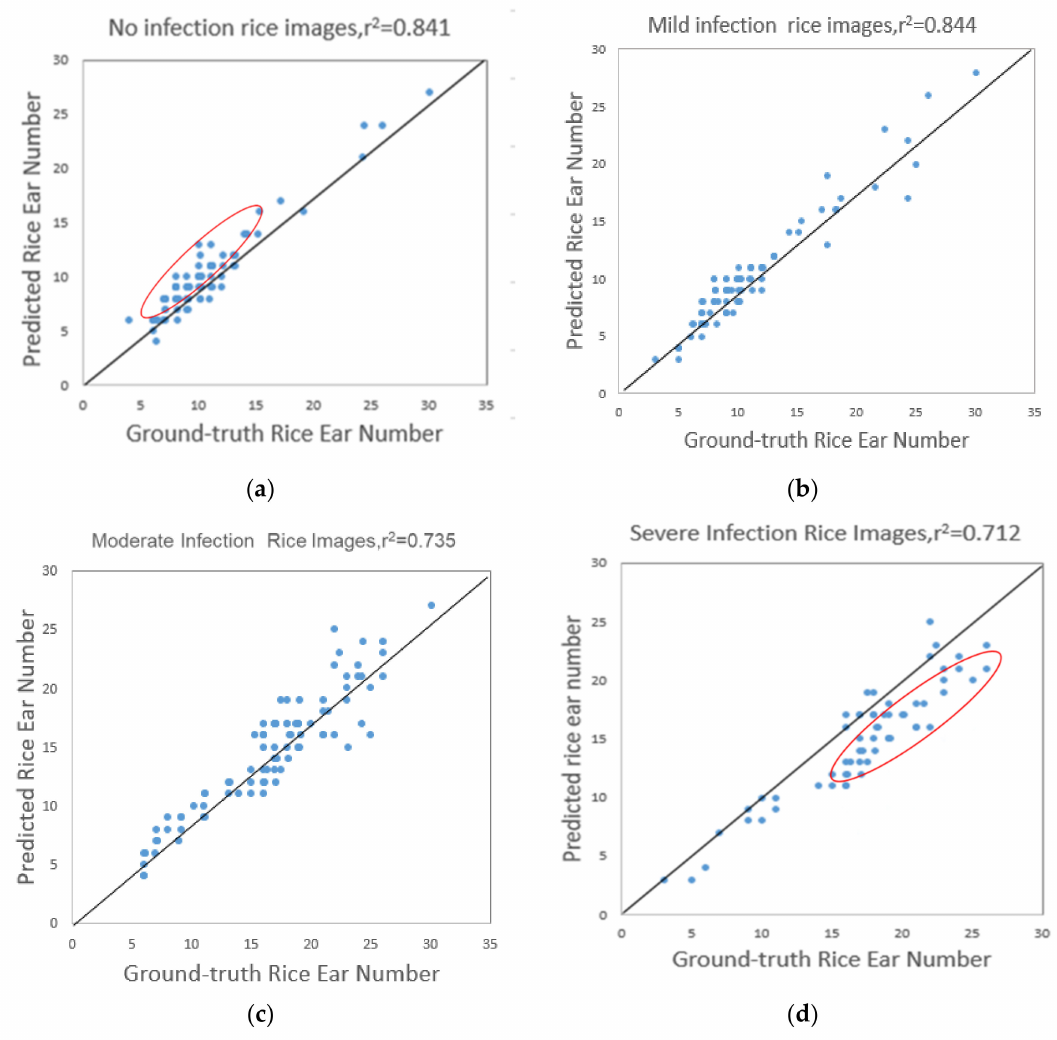
Figure 12. The observed rice ear number vs. predicted rice ear number for no infection rice ( a ); mild infection ( b ); moderate infection ( c ); and severe infection ( d ) diseased rice